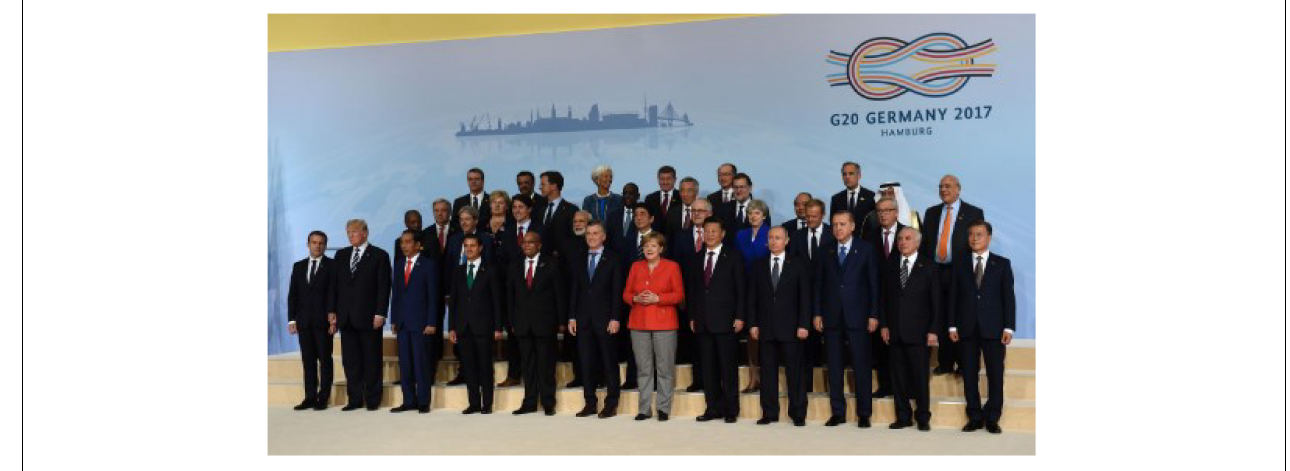
FIGURE 2 | Central image on research instrument: G20 meeting, July 2017.